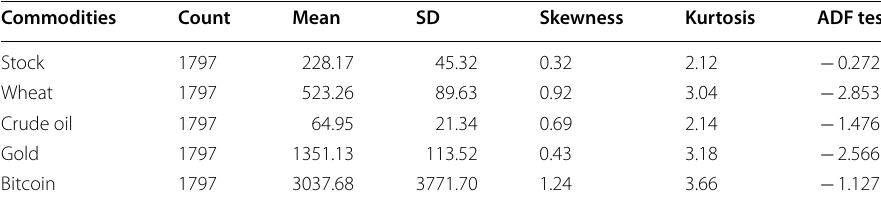
*Statistical significance at the 10% level